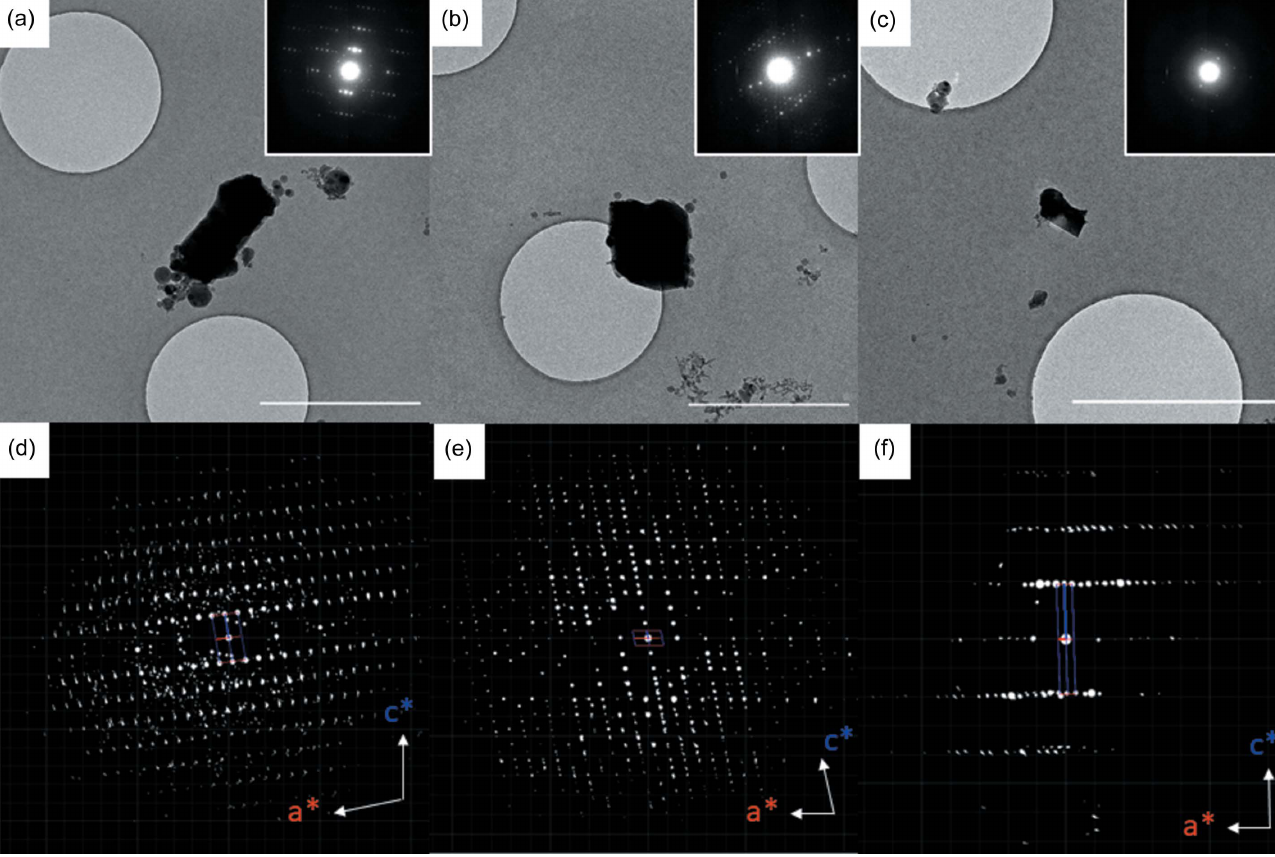
Figure 2 ( a )–( c ) Crystals of form III, IV and II, respectively, found in a sample after crystallization for 30 s on a TEM grid. Scale bars = 2 m m. The insets